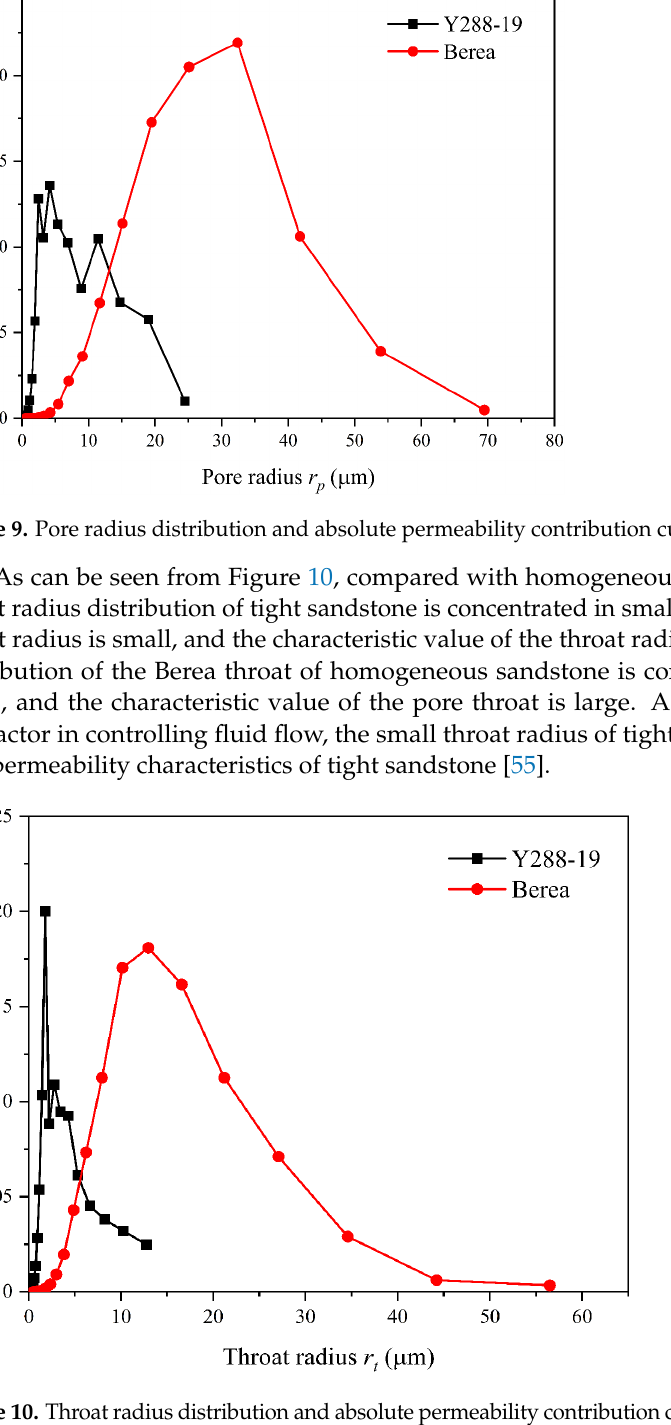
Figure 11. The coordination number of two types of cores. It can be seen from Figure 11 that the overall coordination number of tight sandstone Y288-19 is significantly smaller than that of homogeneous sandstone Berea, indicating that the pore connectivity of tight sandstone is poor, which is also an important reason for the low permeability of tight sandstone. The shape of the pores and throats has a major influence on the simulation of multi- phase flow. In order to use regular geometry to represent complex pore or throat shape, it is necessary to quantitatively characterize the pores and throats of the real core, so the shape factor is introduced. The shape factor G is defined as: